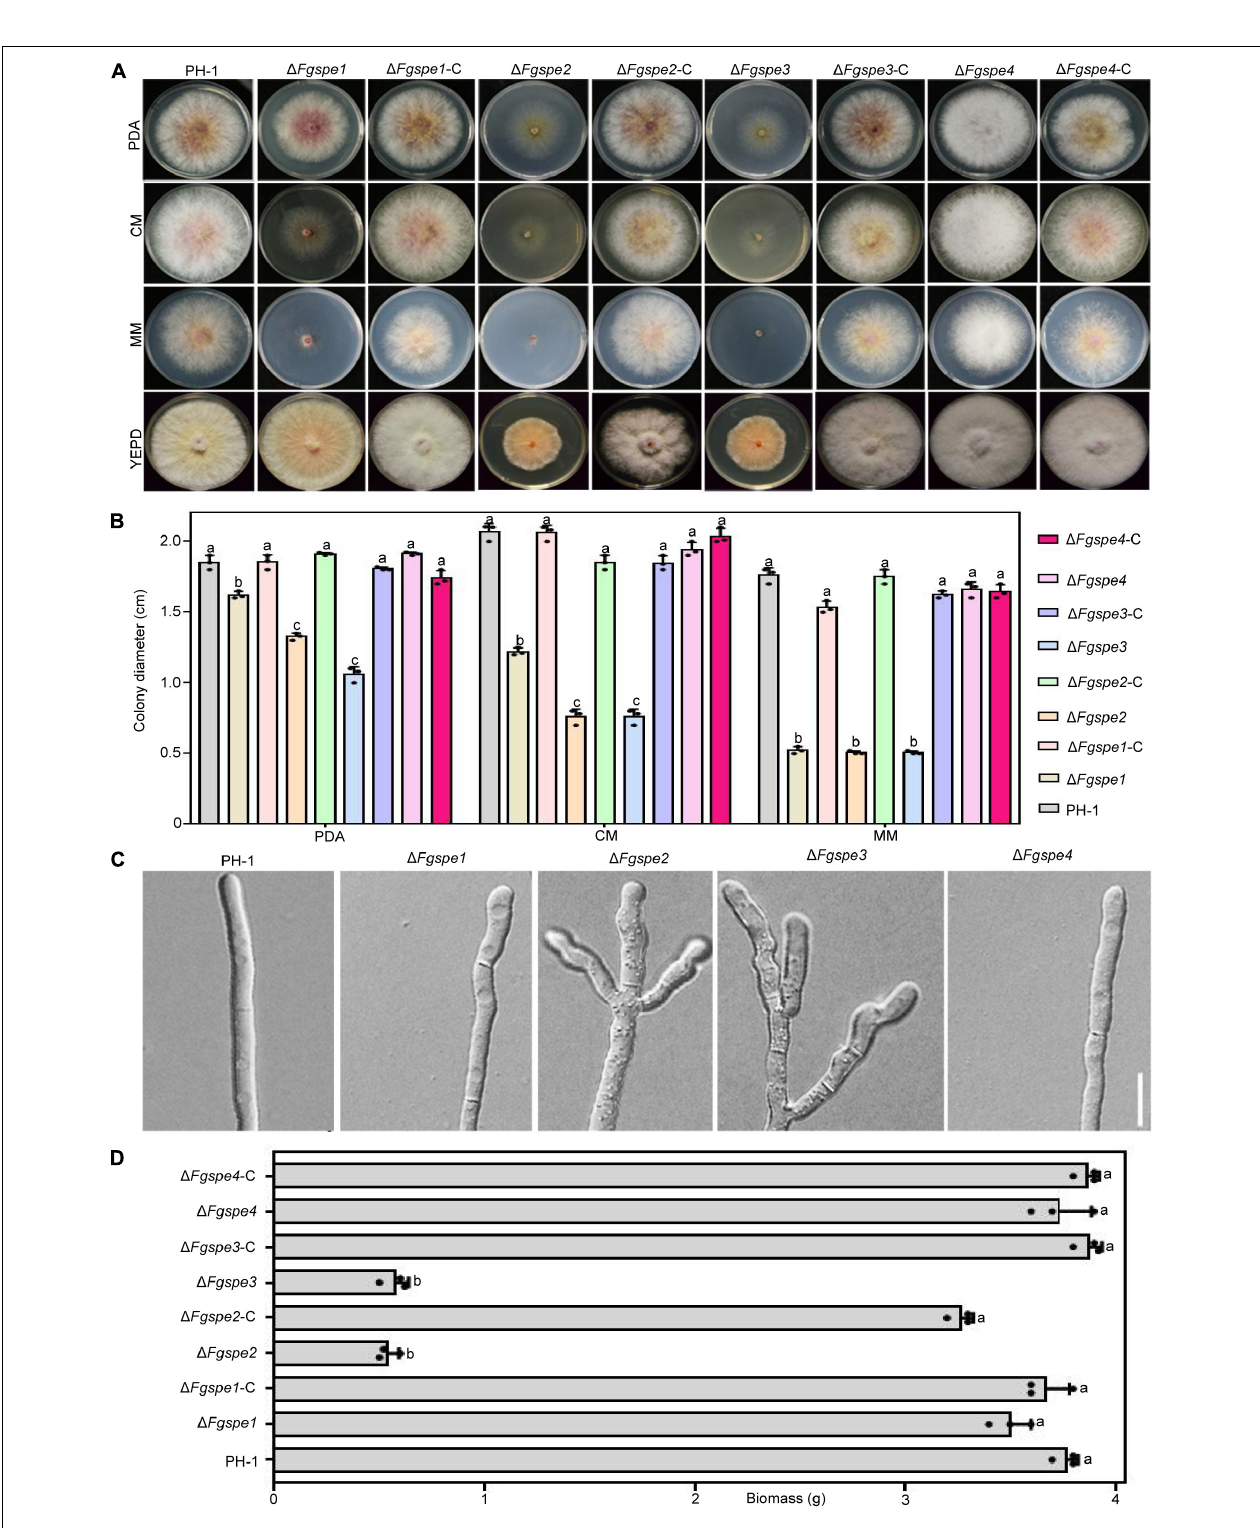
FIGURE 2 | Phenotypes of the (cid:49) Fgspe mutants in vegetative growth. (A) Colony morphology of wild-type PH-1, the (cid:49) Fgspe mutants and complemented strains cultured on PDA, CM, MM, and YEPD medium for 3 days at 25 ◦ C. (B) Statistical analysis of hyphal growth rate of wild-type PH-1 and the mutants. The diameter was measured after culturing at 25 ◦ C for 3 days. Columns listed with the same letter indicates no obviously difference with the least significant difference (LSD) test at P = 0.05. (C) The patterns of hyphal branching and tip growth for wild-type and (cid:49) Fgspe mutants inoculated in PDB liquid medium for 24 h. Bar, 50 µ m. (D) Statistical analysis of biomass of wild-type, the (cid:49) Fgspe mutants, and complemented strains for 2 days in YEPD medium.